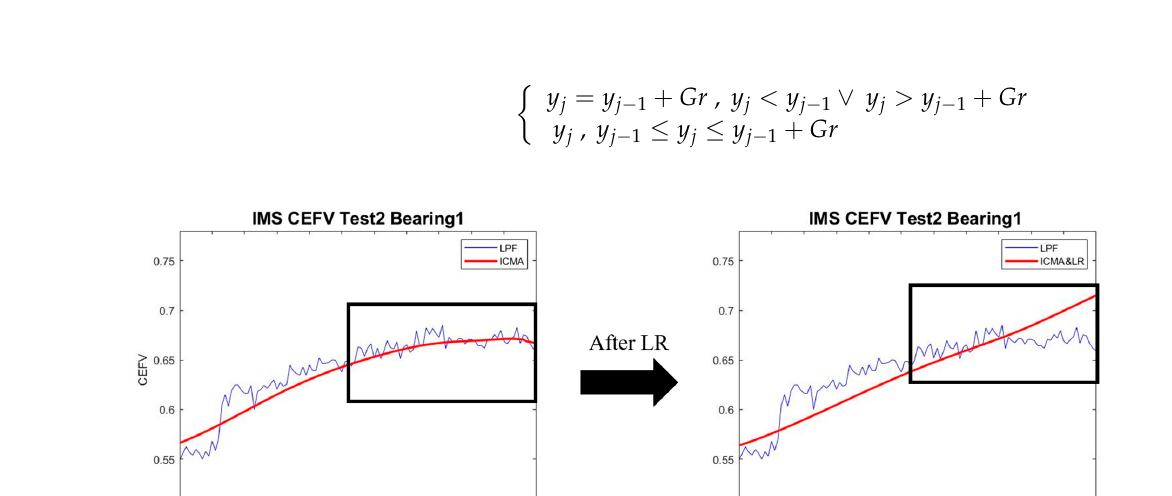
Figure 9. Polynomial regression prediction diagram.